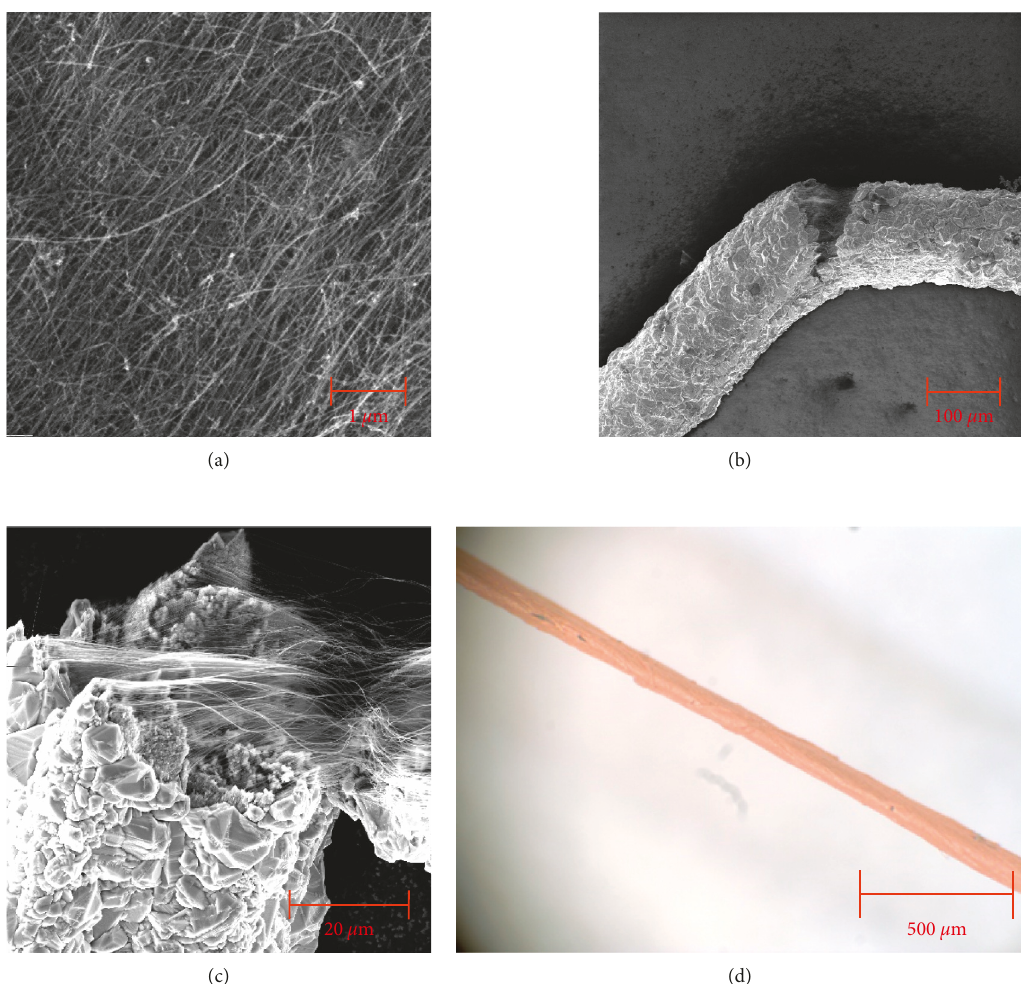
Figure 5: CNT yarn. (a) CNTmorphology before Cu deposition, (b) SEM image of fractured CNT-Cu composite, (c) close-up of fractured composite cross section showing CNTs protruding from surrounding copper, and (d) optical microscope image of composite